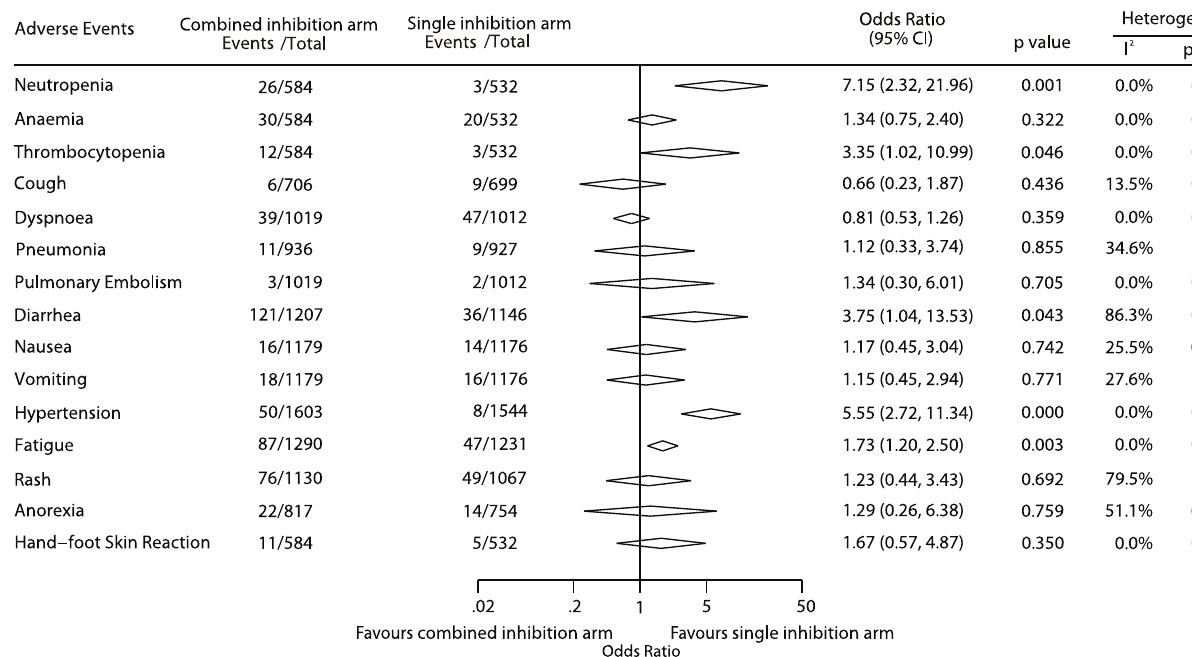
Figure 5. Summary of toxicities grade 3 or greater.